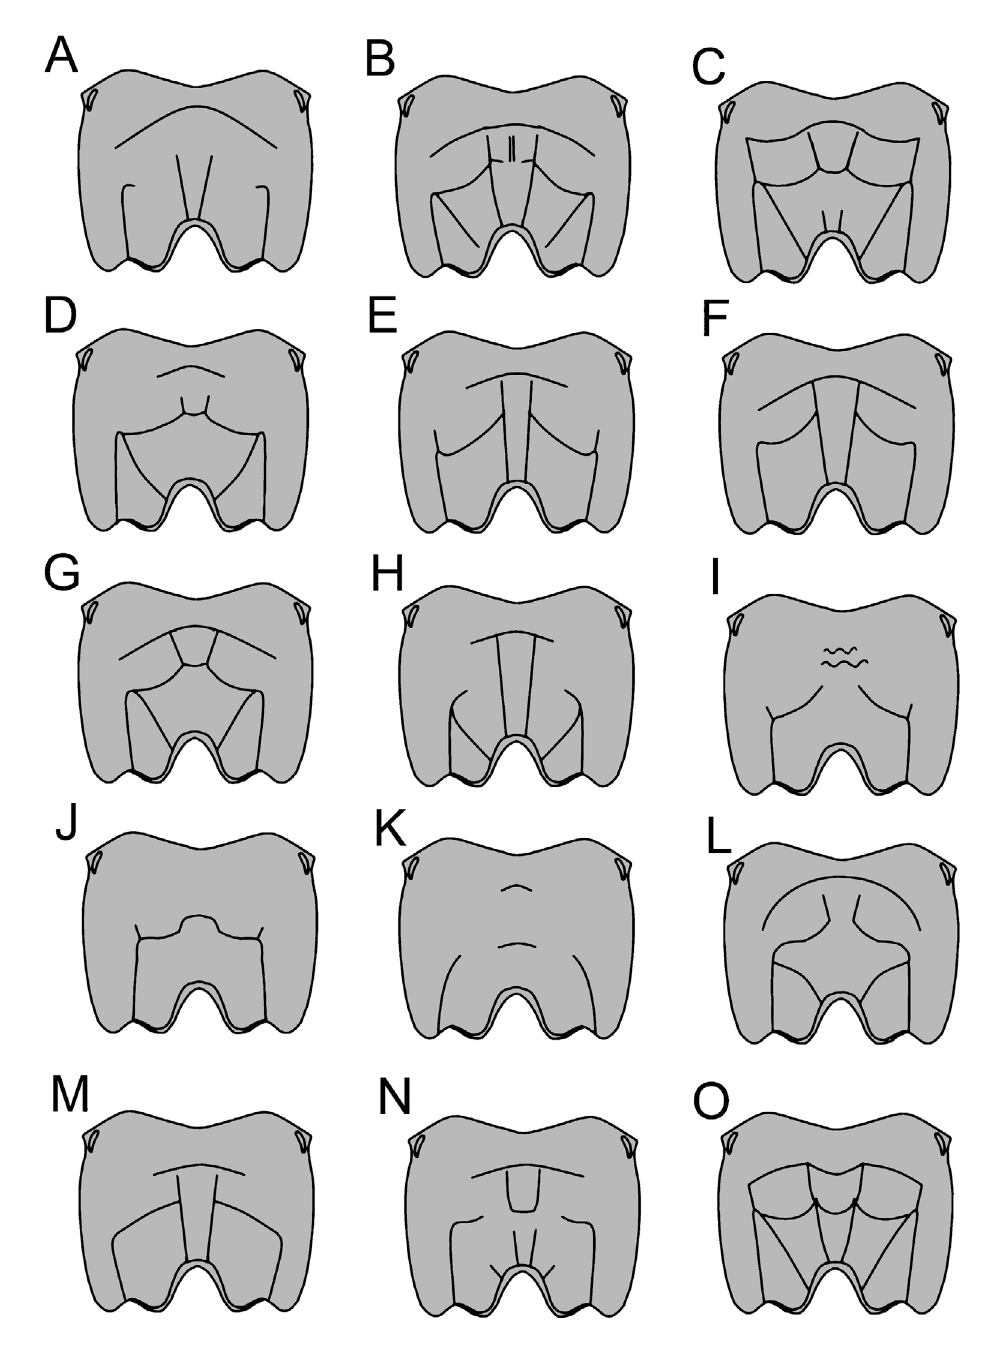
Fig. 10. generalized carination of propodeum in females, posterodorsal view. A . Ophion luteus (Linnaeus, 1758) /O. scutellaris Thomson, 1888 /O. obscuratus Fabricius, 1792. B . O. costatus ratzeburg,